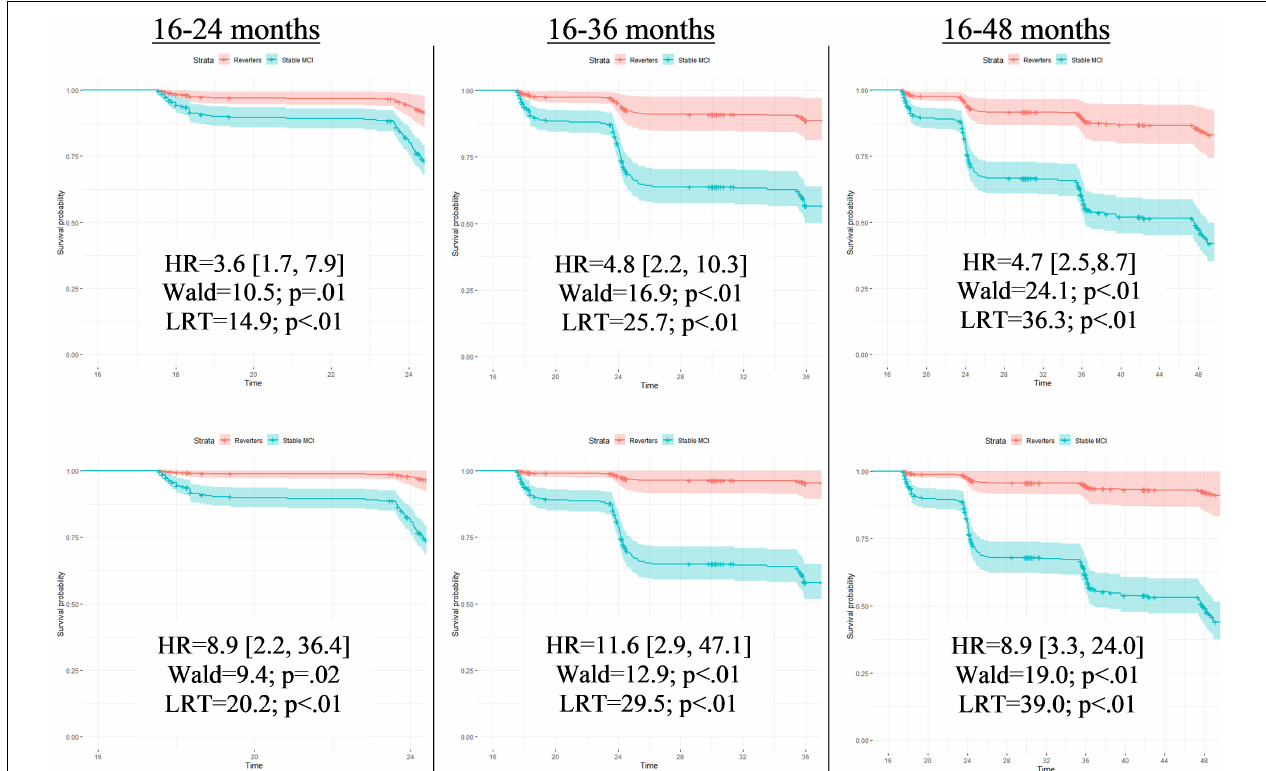
FIGURE 2 | Full Cox proportional models for time until first dementia diagnosis by PE-unadjusted and PE-adjusted 12-month diagnoses. Cox proportional hazard models compared progression to dementia between those who were classified with mild cognitive impairment at follow-up (Stable MCI) and those who reverted to cognitively normal (Reverters). All models used classifications (Stable MCI vs. Reverter) as the independent variable of interest and months from baseline until first dementia diagnosis as the dependent variable. Covariates were age and education, fixed at the average level within the sample (age: 73.1 years; education: 16.4 years). Models in the top row display results completed with PE-unadjusted scores; models in the bottom row display results completed with the PE-adjusted scores. Each row designates the time frame for each model measured in months from baseline. Time frames were restricted to demonstrate how predictive the classification was for studies with various follow-up periods. As these hypothetical studies would not know if a participant converted to dementia past their follow-up period, those who converted after the endpoint of that specific model were censored (i.e., recoded as non-converters). Each model presents a hazard ratio (HR; [CI]) that indicates how much more likely the Stable MCI group was to convert to dementia compared to the Reverters. Wald tests and likelihood-ratio tests (LRT) are also included with associated p -values to denote the significance of the HR. The Y -axis of each of the 6 models provides the survival probability and the X -axis of each model provides the time frame until dementia